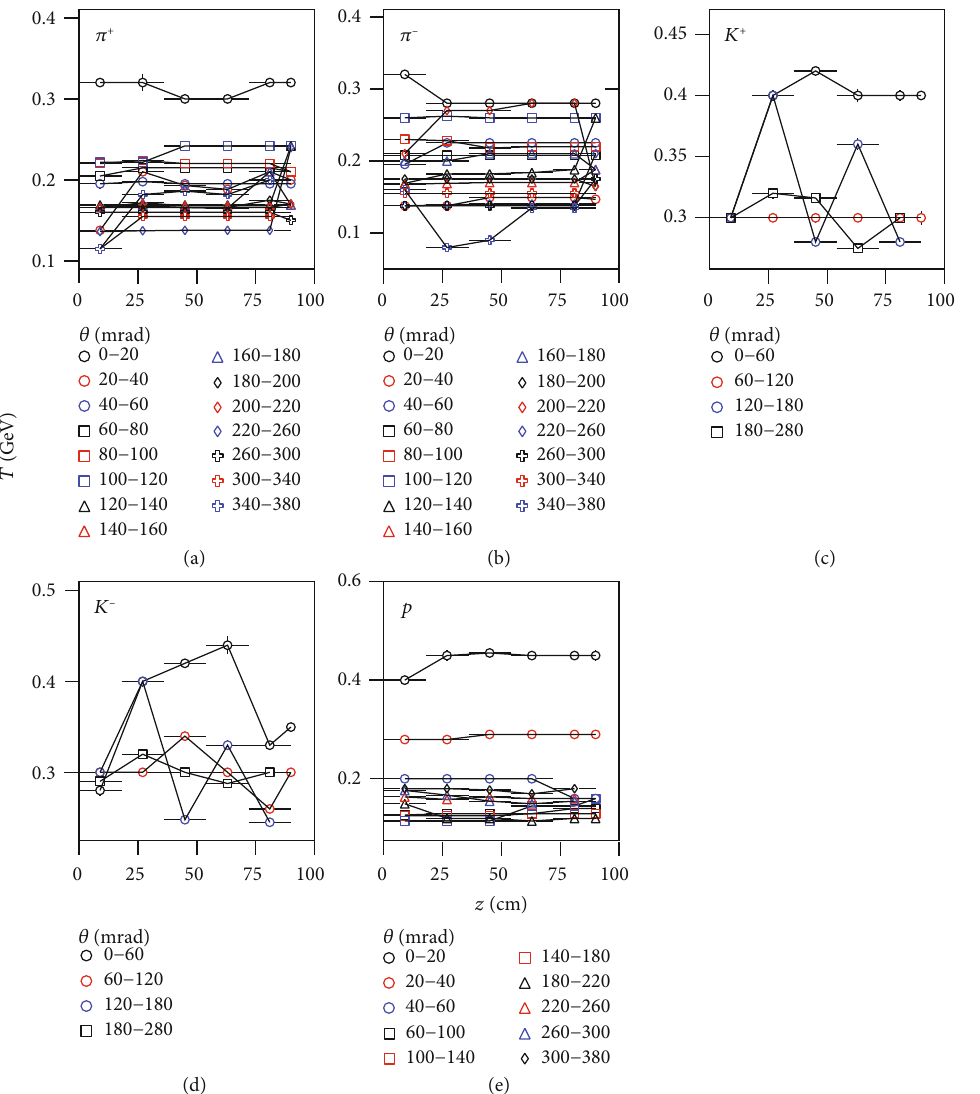
Figure 9: Dependence of T on z , which are extracted from the data samples within di ff erent θ ranges for (a) π + , (b) π − , (c) K + , (d) K − , and (e) p